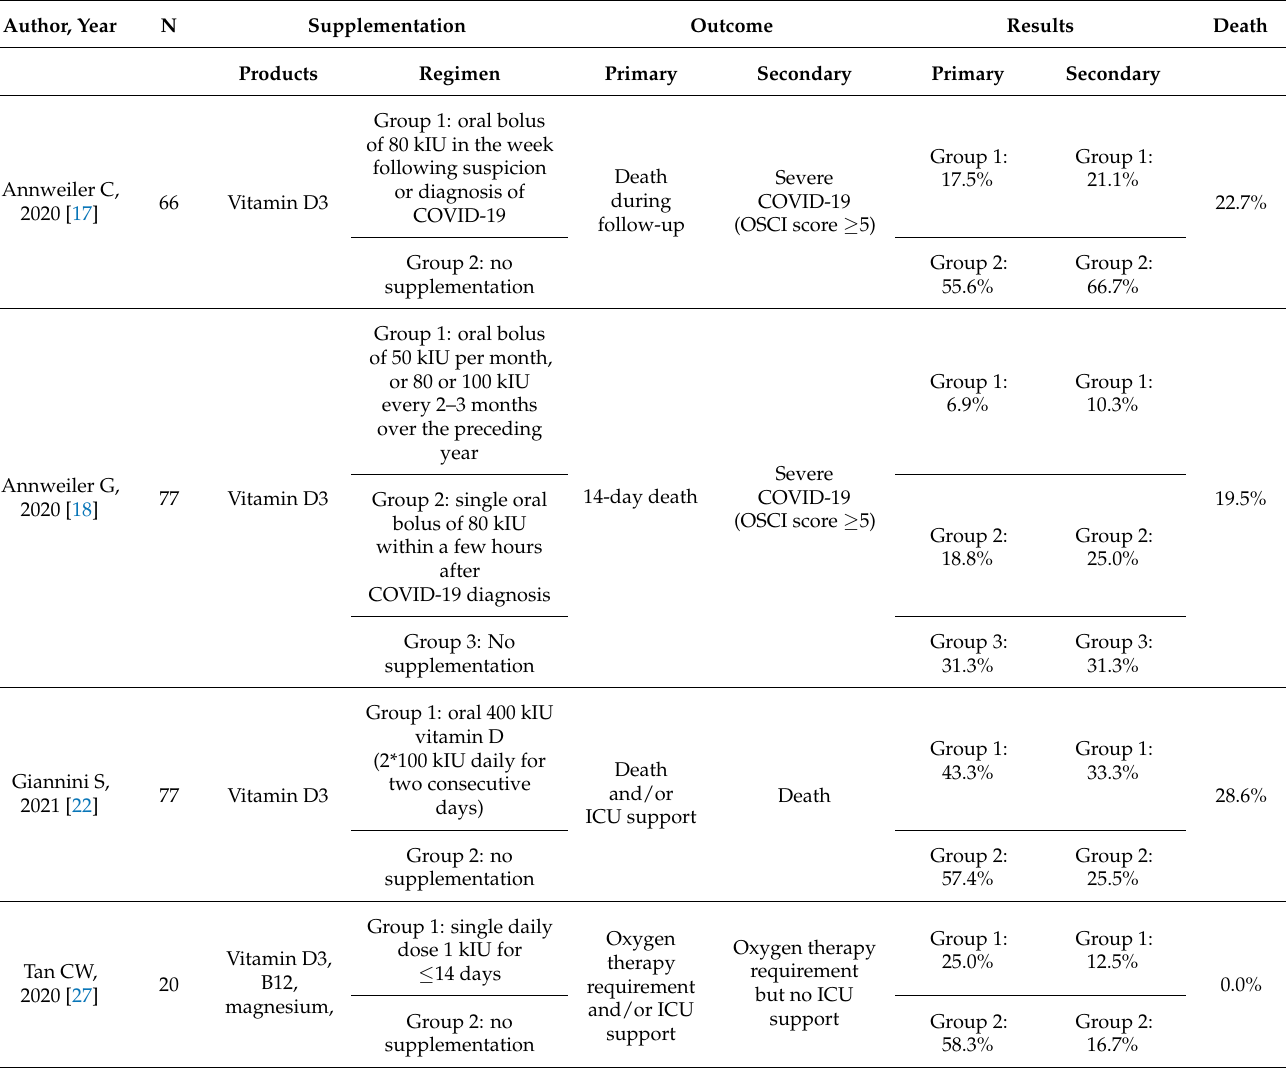
Table 2. Description of outcome criteria and results for the association between vitamin D supplementation and COVID-19 in elderly